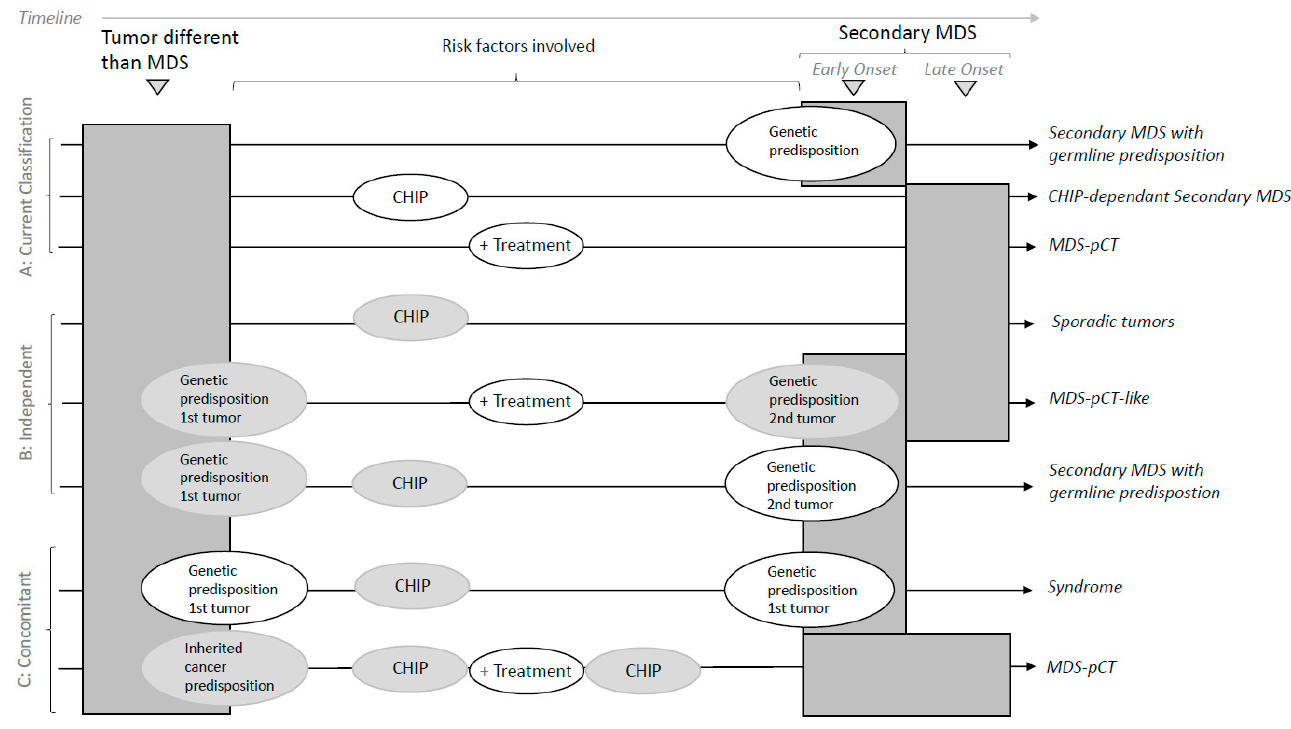
Figure 2. Classification of secondary MDS. The risk factors involved in different etiologies are shown for the primary tumor and secondary MDS. Risk factors in white circles refer to mandatory conditions per the scenario described. Risk factors in grey circles refer to non-strictly necessary overlapping conditions co-occurring with the mandatory condition. The timeline shows the chronology of tumor events. The expected time of onset is shown for secondary MDS. Early onset is expected when MDS involves genetic predisposition. ( A ) Current classifications are based on well-delimited